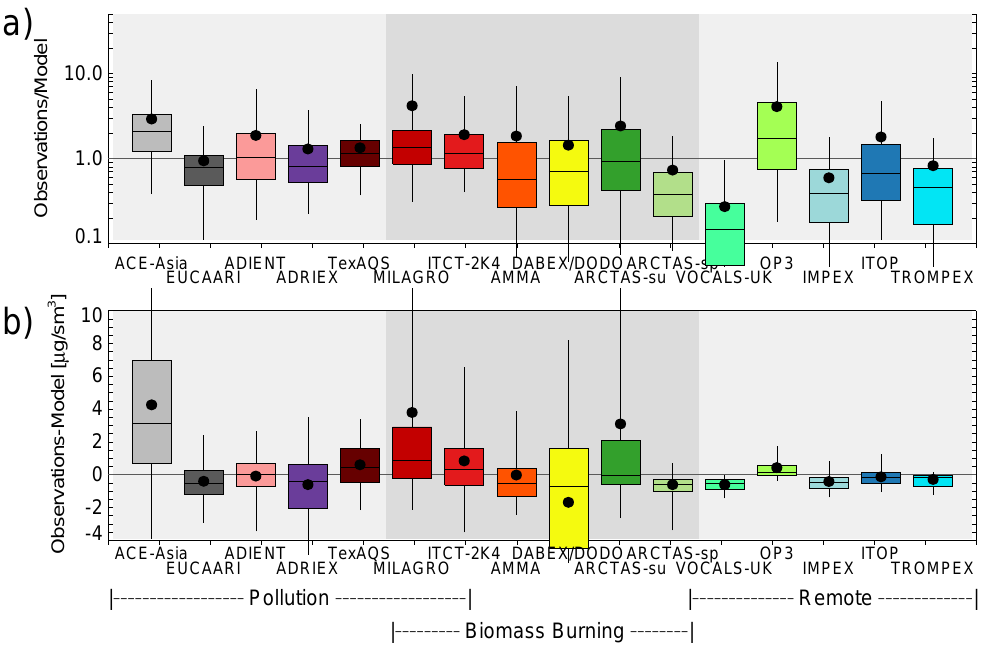
Fig. 13. As in Fig. 6, but with the 30-fold of increase in ASOA in the model and the reduction of the enthalpy of vaporization of SOA to 25kJmol − 1